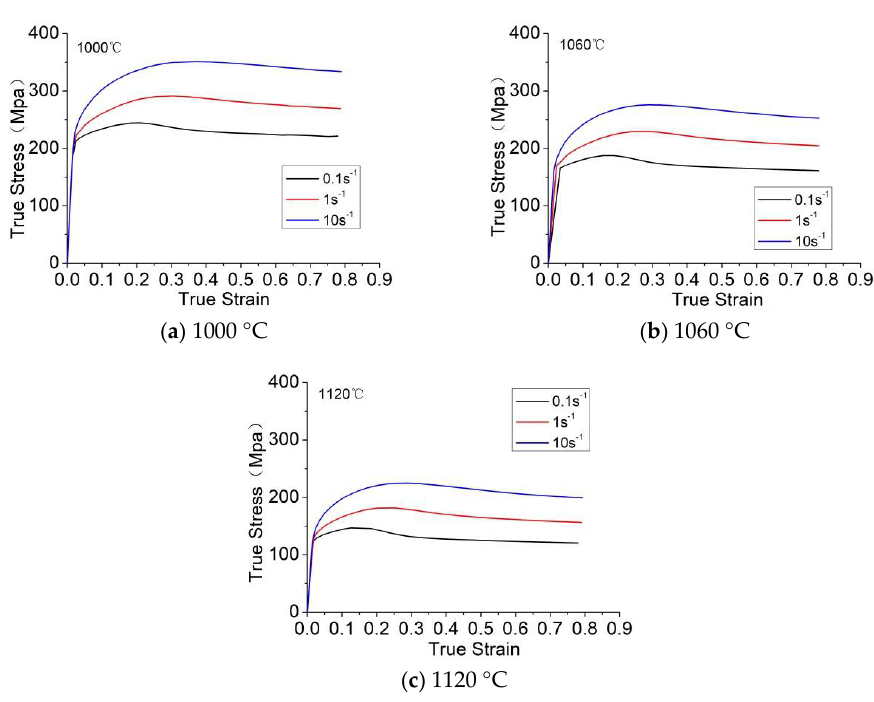
Figure 3. Compressive true stress-true strain curves of the 21-4N with various strain rates.